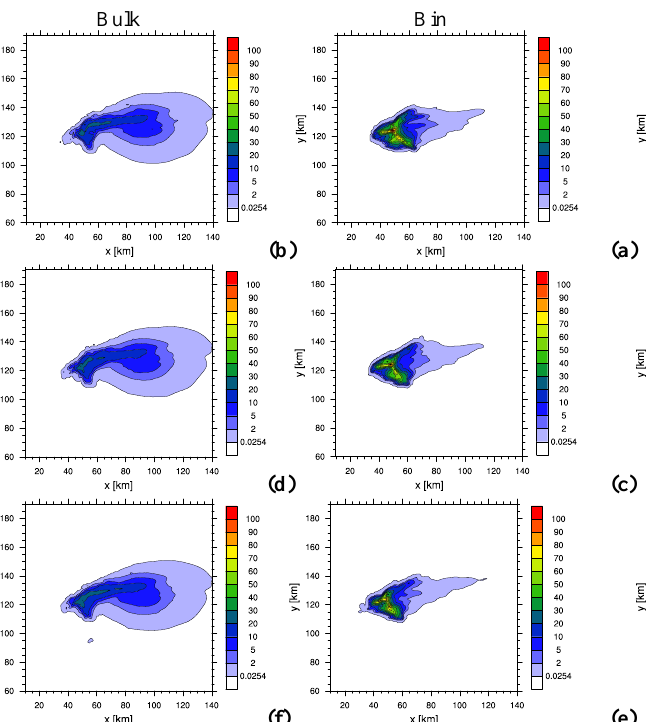
Fig. 5. As in Fig. 4 except after 4h of simulation